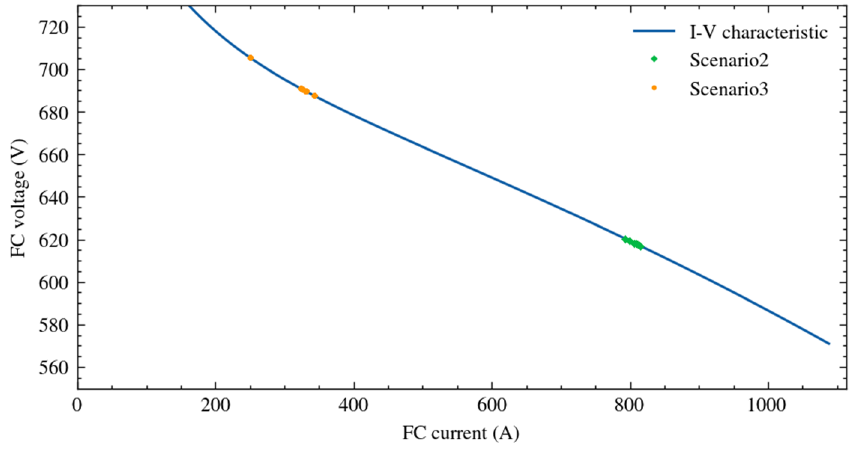
Figure 12. Simulated FC operating points superimposed to the FC’s I-V characteristic in Scenarios 2 and 3.